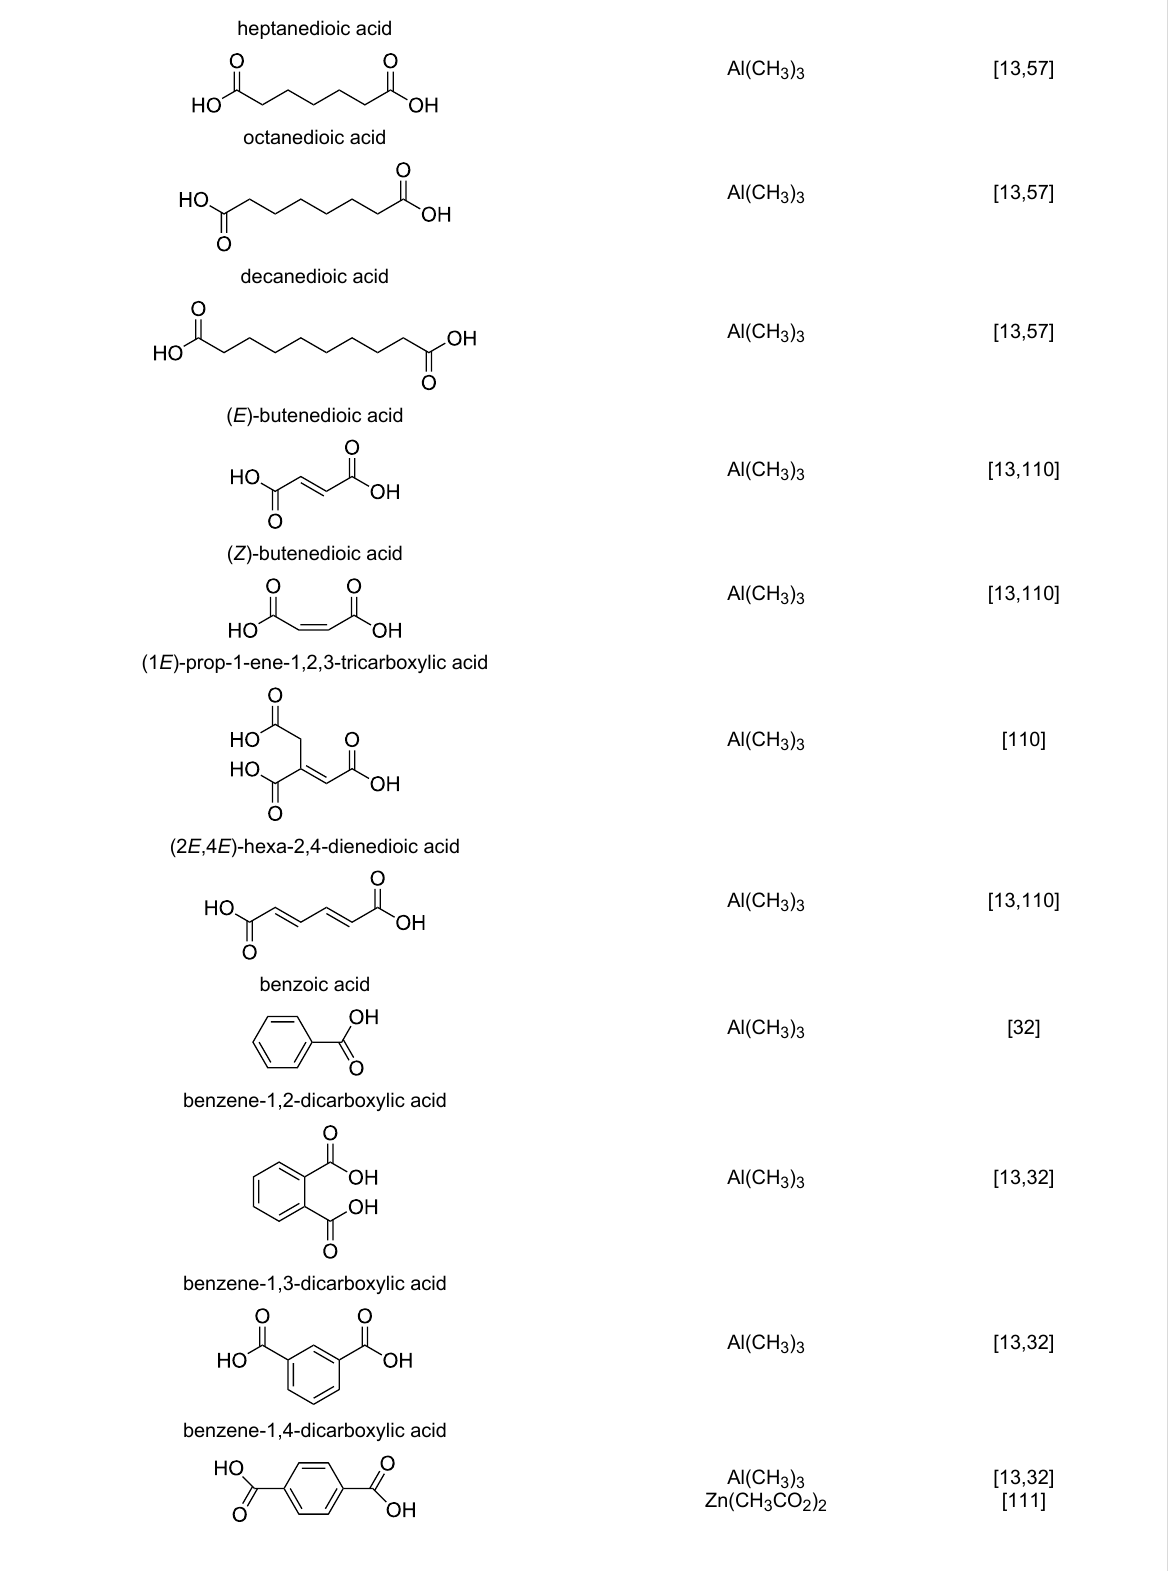
Table 12: Carboxylic acid precursors used to deposit inorganic–organic hybrid thin films.